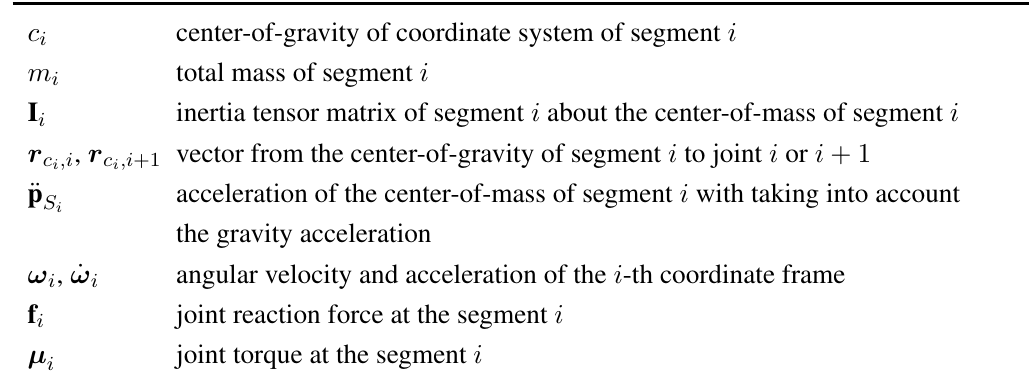
Table 1. Description of parameters of Newton–Euler inverse dynamics